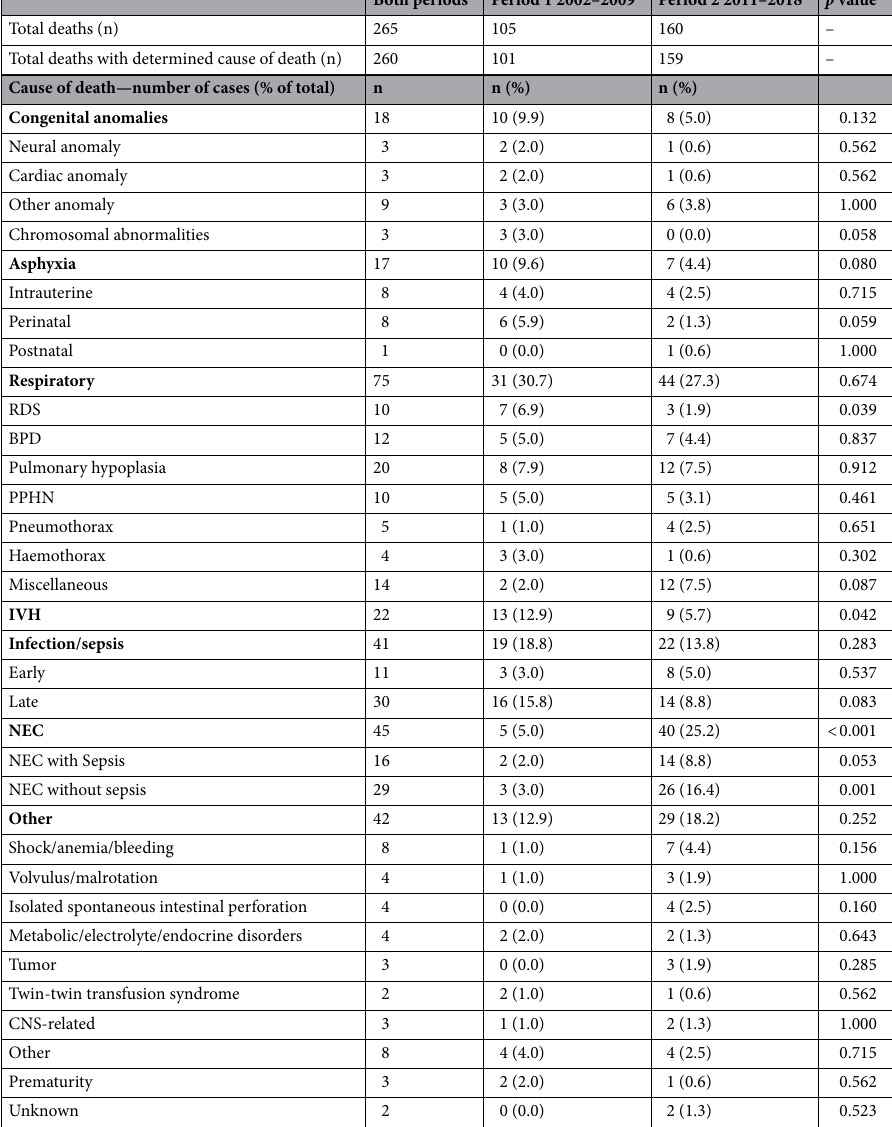
Table 3. Cause of death in relation to year of